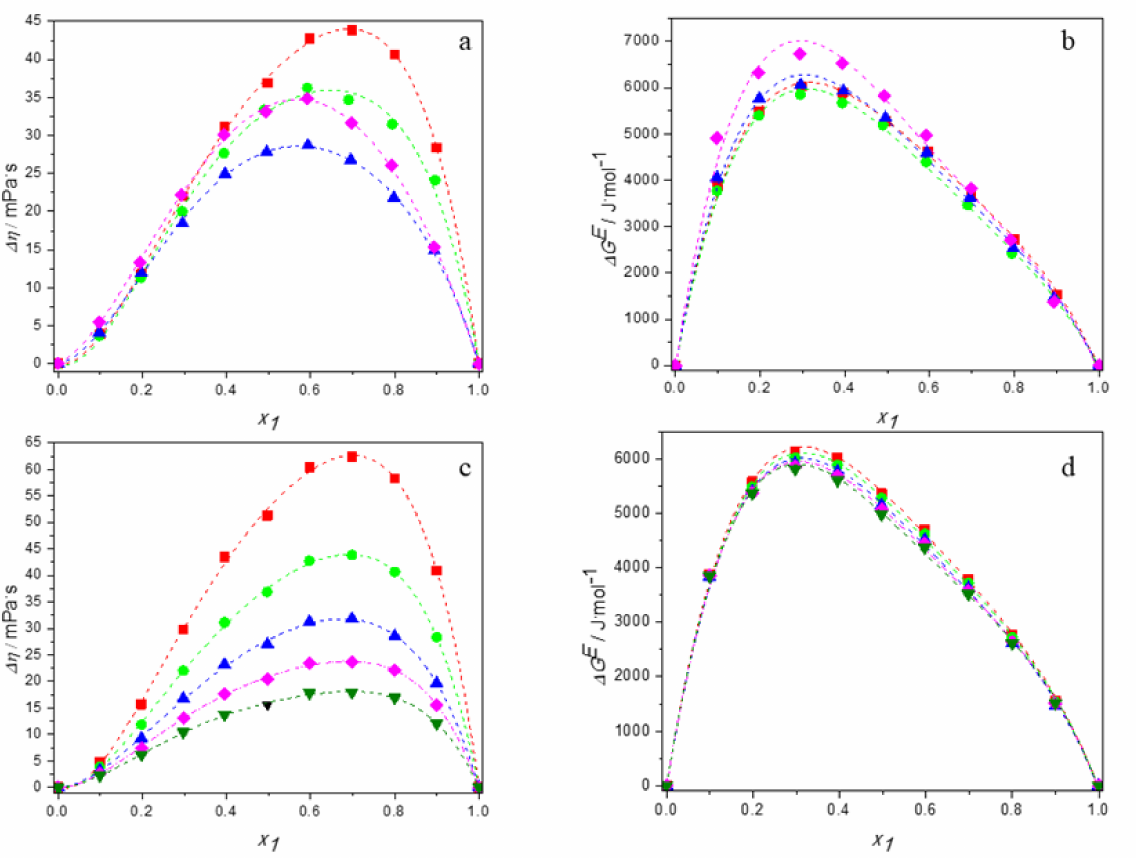
Figure 9. Dependence of the deviations in viscosity and the excess Gibbs energy of activation of aqueous solutions of DESs on molar fraction of deep eutectic solvent: ( a , b ) at 298.15 K for (cid:4) DES1; • DES2; (cid:78) DES3; (cid:7) DES4; ( c , d ) for DES1 at 298.15 K ( (cid:4) ); 298.15 K ( • ); 303.15 K ( (cid:78) ); 308.15 K ( (cid:7) ); 313.15 K ( (cid:72) ); —, Equation